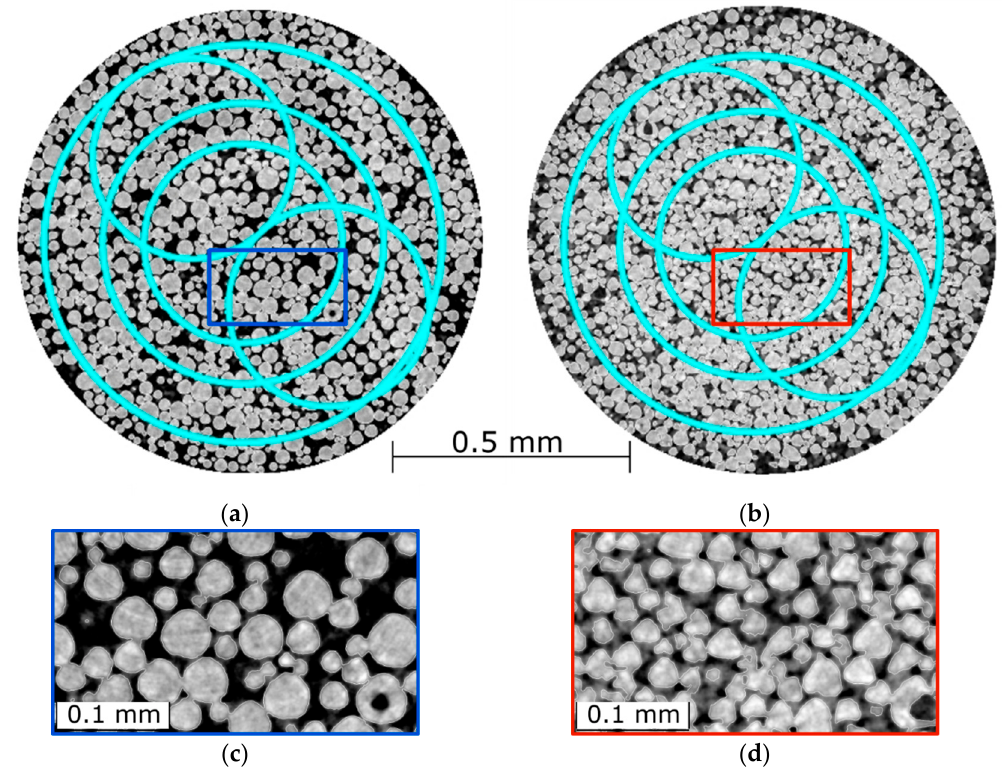
Figure 1. ( a ) Ti–6Al–4V and ( b ) steel 316L laser beam melting (LBM) powder in glass capillary. The analyzed regions of interest (ROI) (turquoise, VG Studio MAX 3.2) are also shown. Enlarged view for Ti–6Al–4V (blue box) ( c ) and for steel 316L (red box) ( d ).